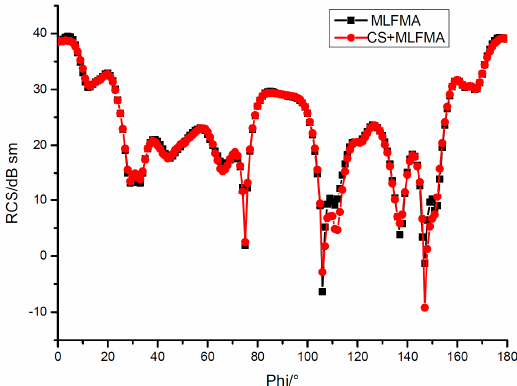
Figure 8. The relative error of the current of ship model by MLFMA and CS-MLFMA based on DCT basis.